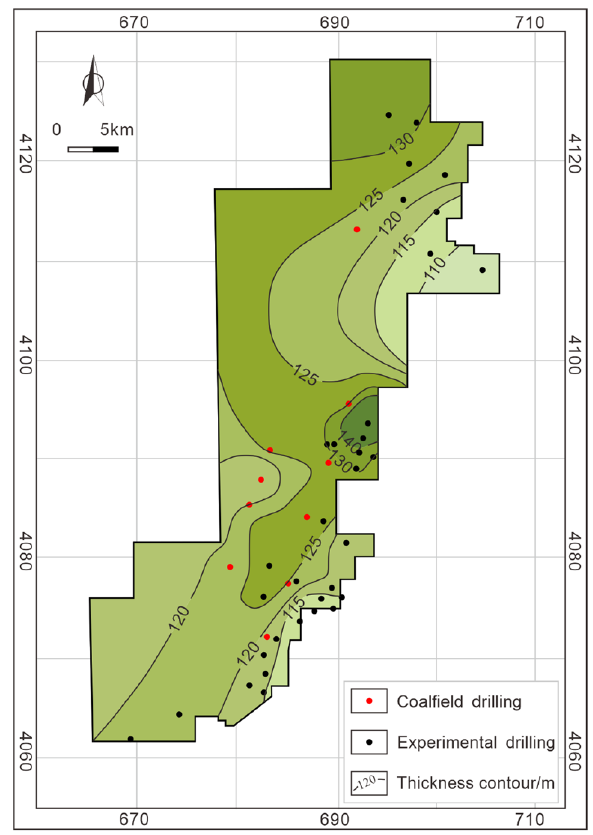
Figure 8. Thickness contour of the Taiyuan Formation in the study area.